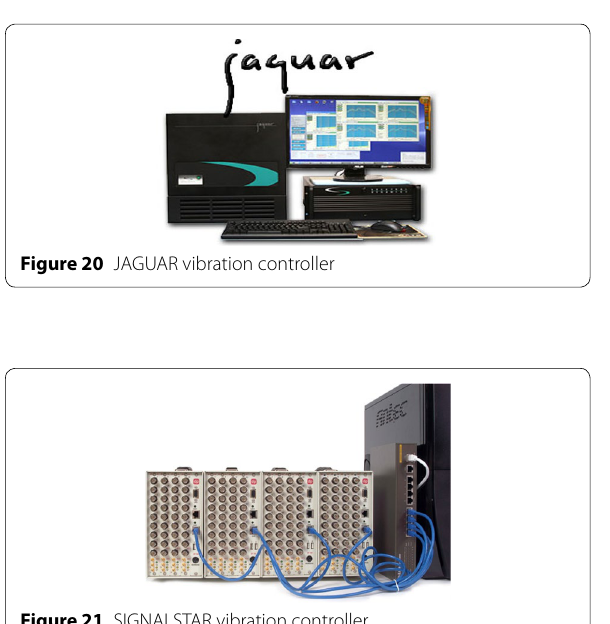
Figure 21 SIGNALSTAR vibration